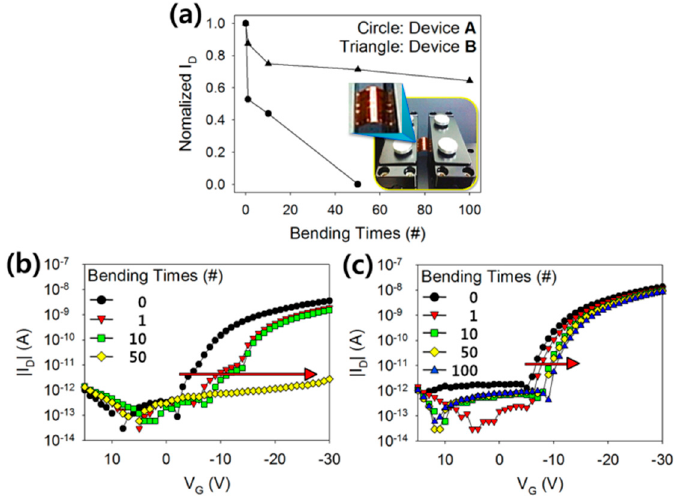
Figure 7. ( a ) Variations in the drain current of the fabricated TFTs, induced by cyclic bending stresses. Transfer characteristics of the flexible TIPS-pentacene TFTs with the ( b ) c-PVP/Y 2 O 3 composite and ( c ) c-PVP gate insulators, measured during cyclic bending stress tests.